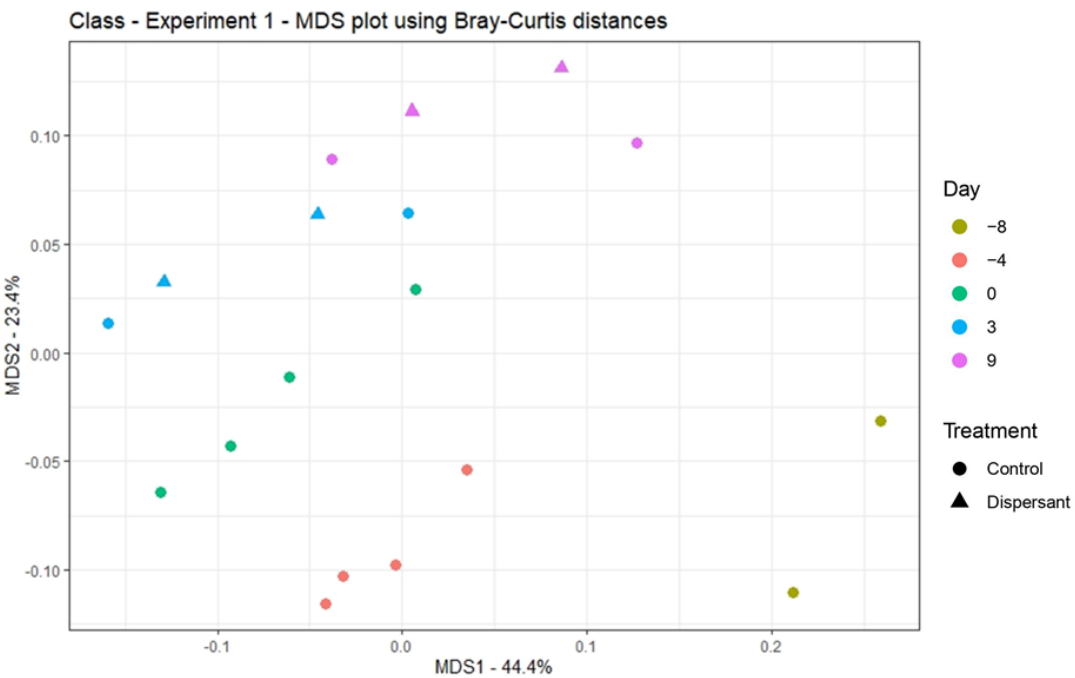
Figure 2. Principal coordinate analysis (PCoA) of bacterial communities, evaluated to class level, using Bray–Curtis distance. Symbols represent control (●) and dispersant (Δ), and color codes represent the different sampling points: yellow (day −8), red (day −4), green (day 0), blue (day 3), and purple (day 9).